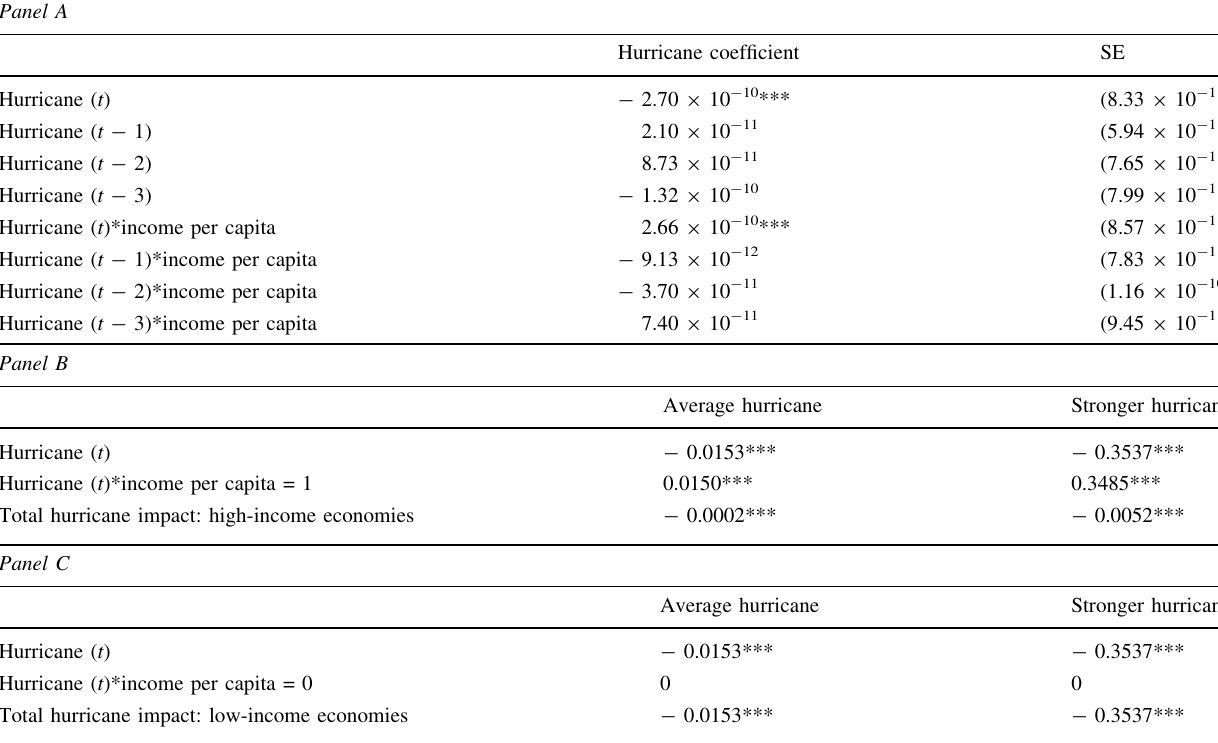
Table 7 Impact of hurricanes on production efficiency by income per capita in the 17 Caribbean countries in the case